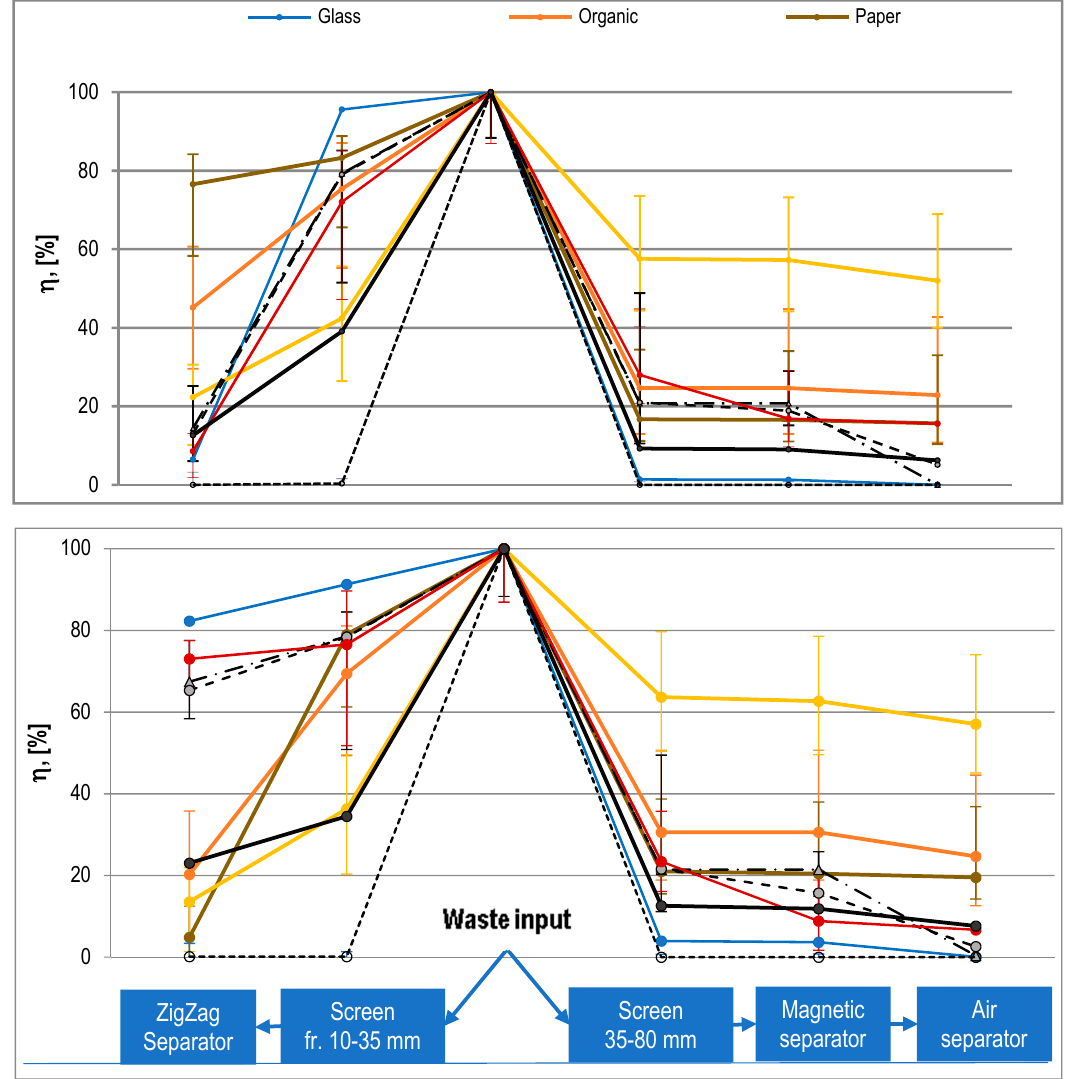
Figure 3. Recovery ( η ) of material components in subsequent stages of the CLO processing (average values: waste from Marszów 13 series, entrusted waste 6 series).